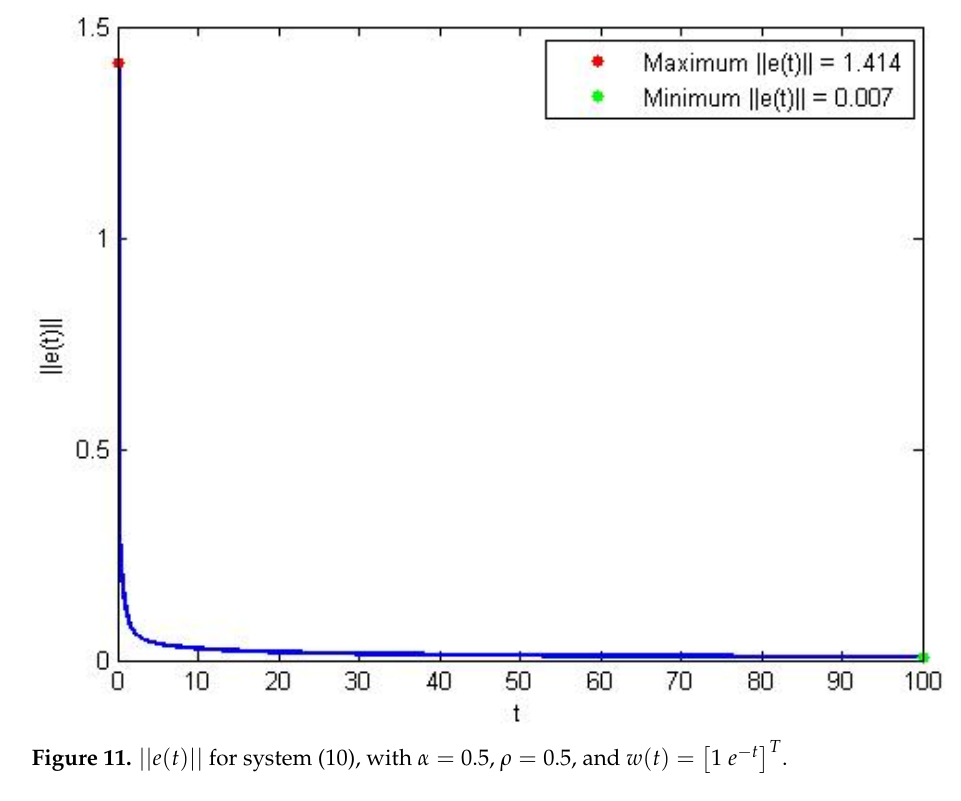
Figure 10. ‖𝜑(𝑡)‖ for system (10), with 𝛼 = 0.5 , 𝜌 = 1.5, and 𝑤(𝑡) = [1 𝑒 −𝑡 ] 𝑇 .